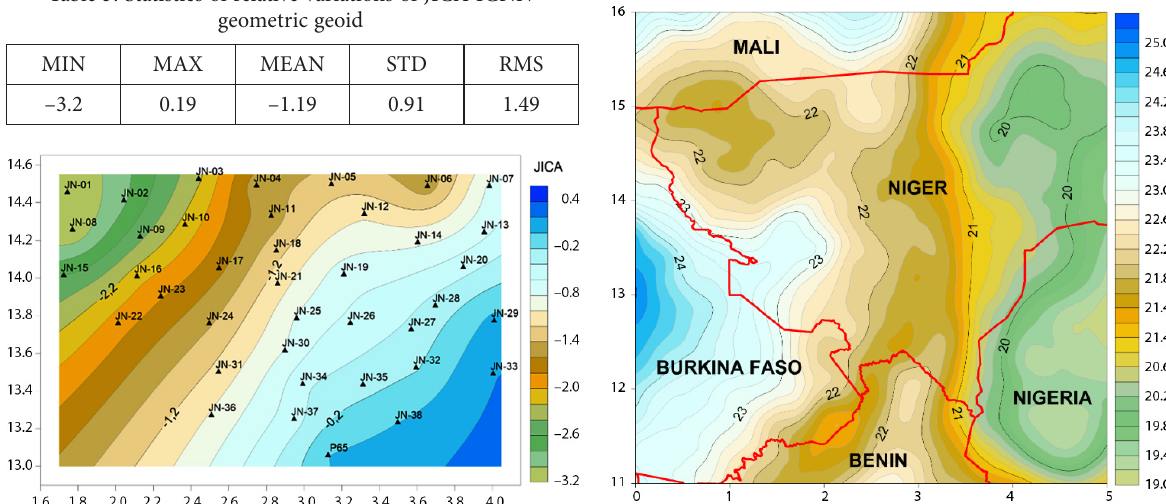
Fig. 4. Relative geometric geoid in meters on WGS84 (reinterpolated)